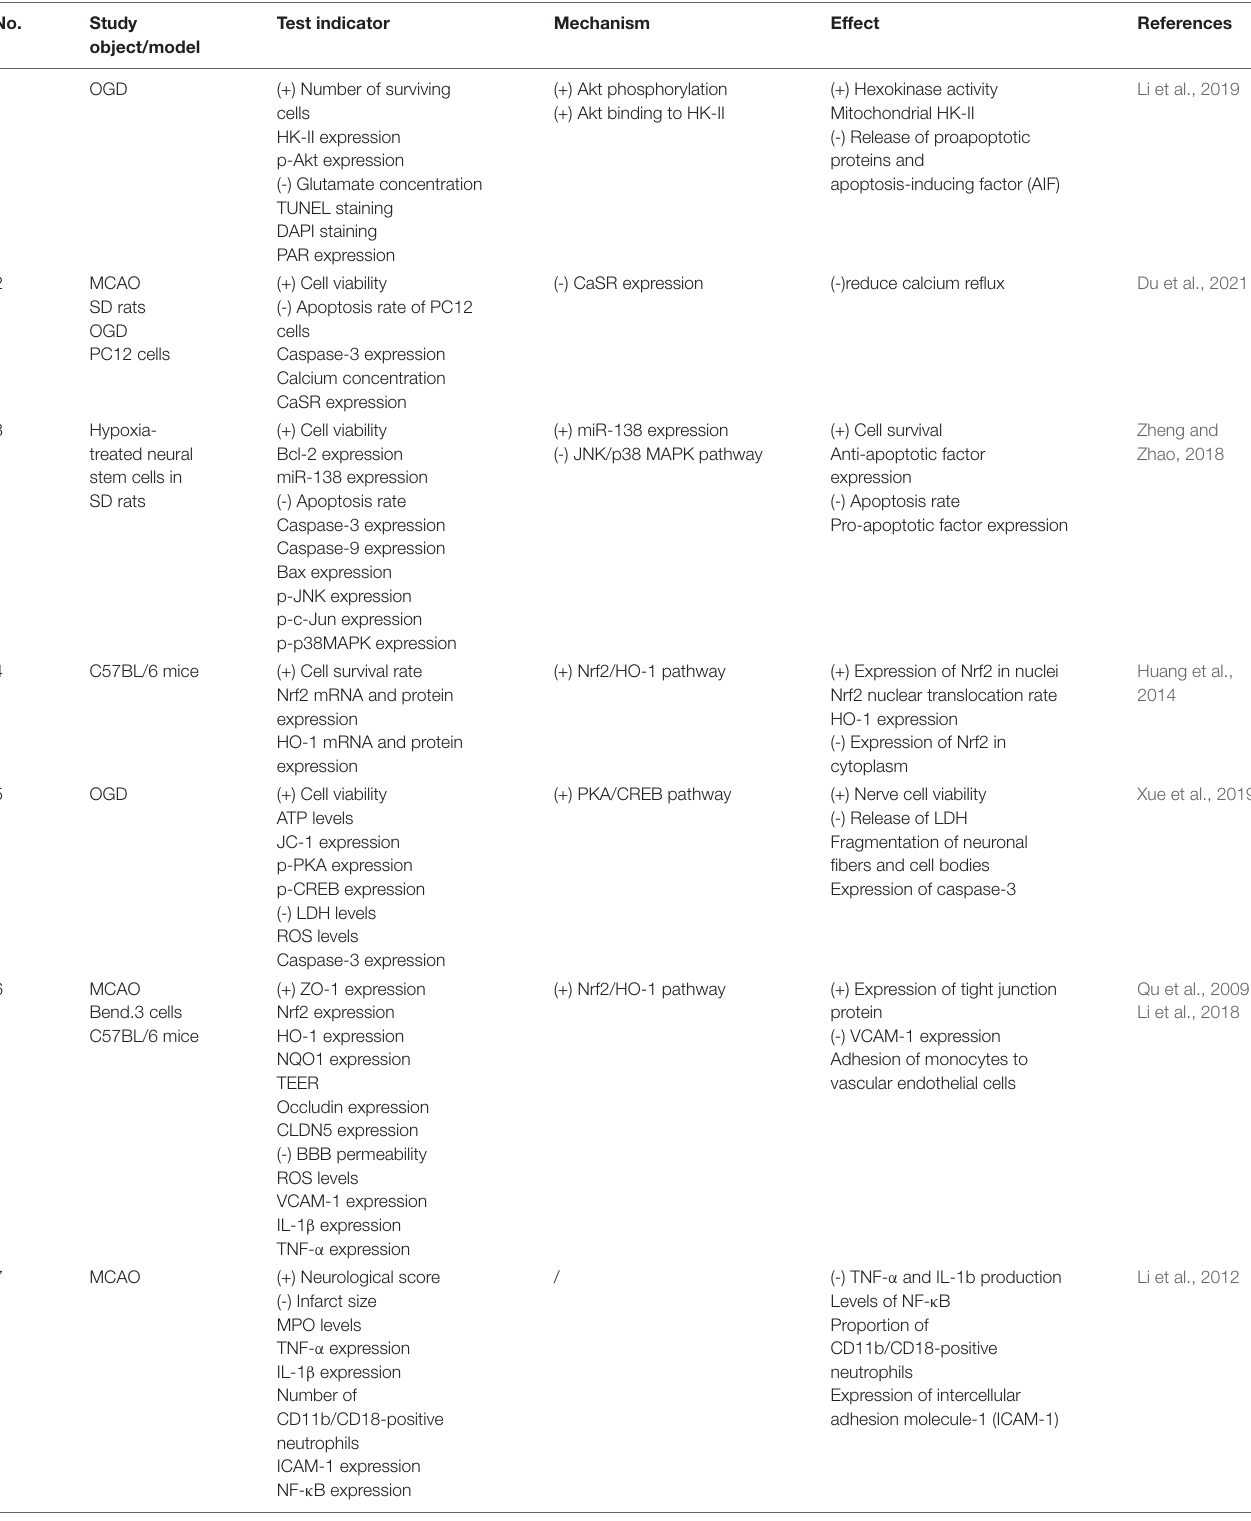
TABLE 1 | Protective effect and mechanism of astragaloside IV against cerebral ischemia-reperfusion injury.